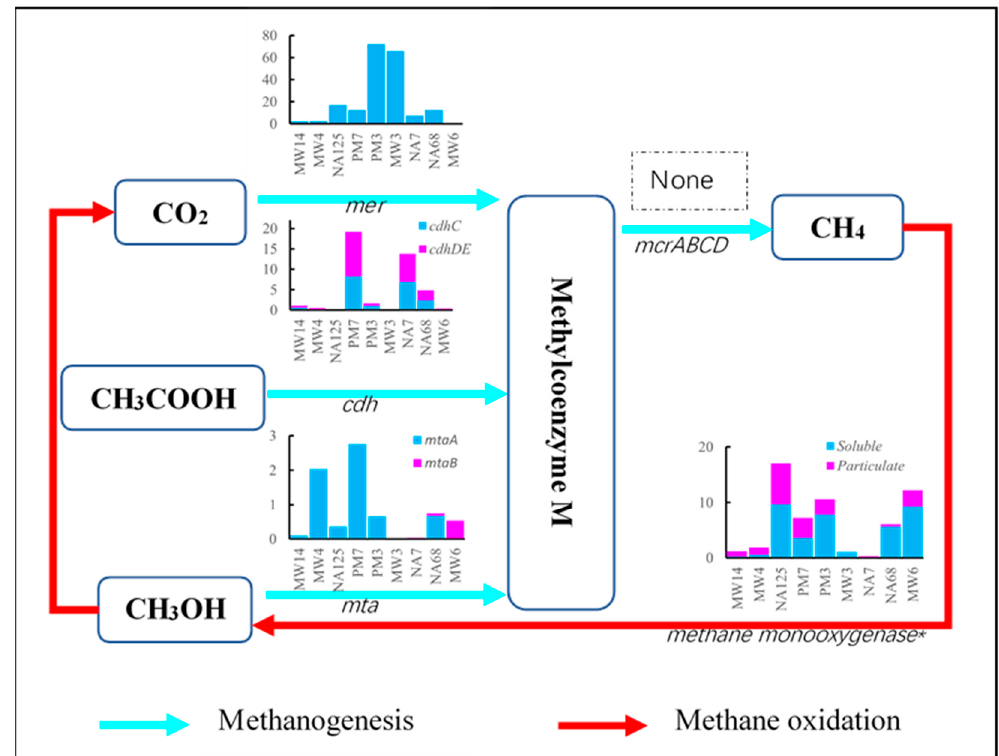
Figure 3. Gene abundance of methane metabolic pathways in the aquifer.